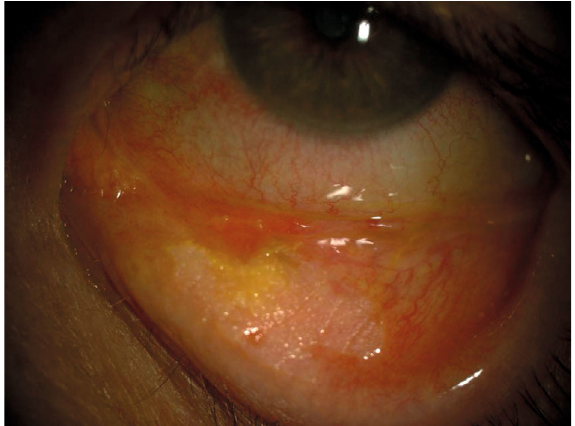
Figure 1: Image with the presence of a leukoplakia measuring 1cm in length on the lower left eyelid tarsal conjunctiva.